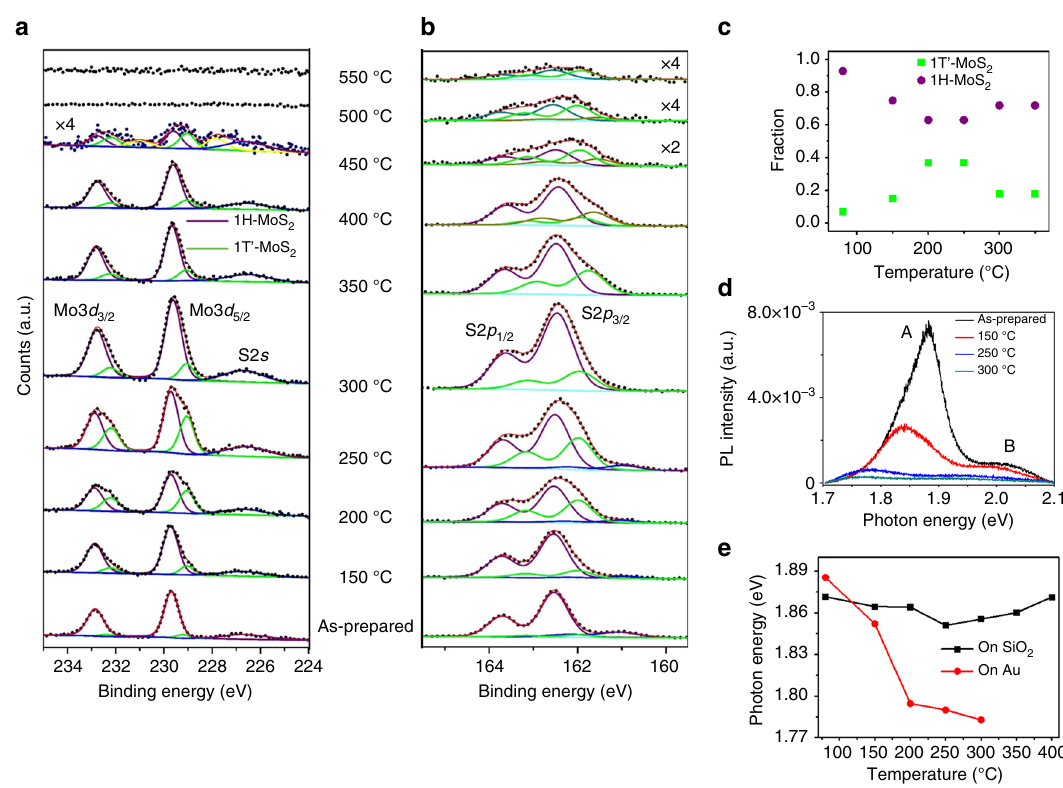
Fig. 3 Annealing temperature dependence of photoemission and photoluminescence spectroscopy. a Mo-3 d and b S-2 p spectra for MoS 2 /Au after annealing at respective temperatures. c Extracted relative fraction of 1H-MoS 2 and 1T ’ -MoS 2 components of Mo-3 d 5/2 peaks as functions of temperature. d The photoluminescence spectra of monolayer MoS 2 on Au electrode in the device (Fig. 2b) at respective temperatures. e Extracted photoluminescence energy position of peak A as a function of temperature, compared with that of MoS 2 on SiO 2